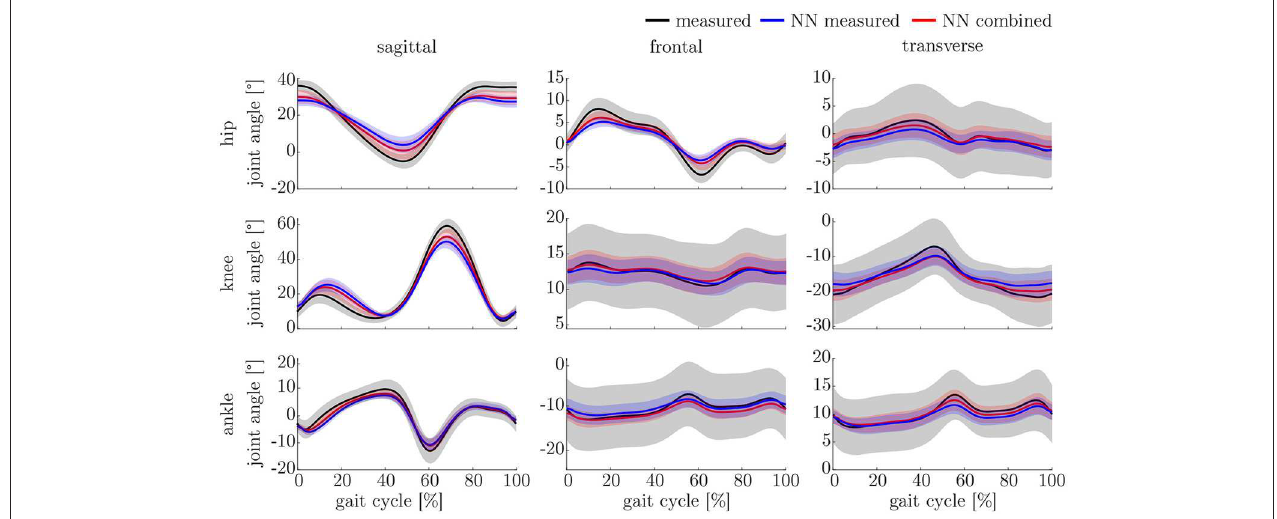
FIGURE 11 | Overview of the mean and standard deviation of the joint angles of the 23